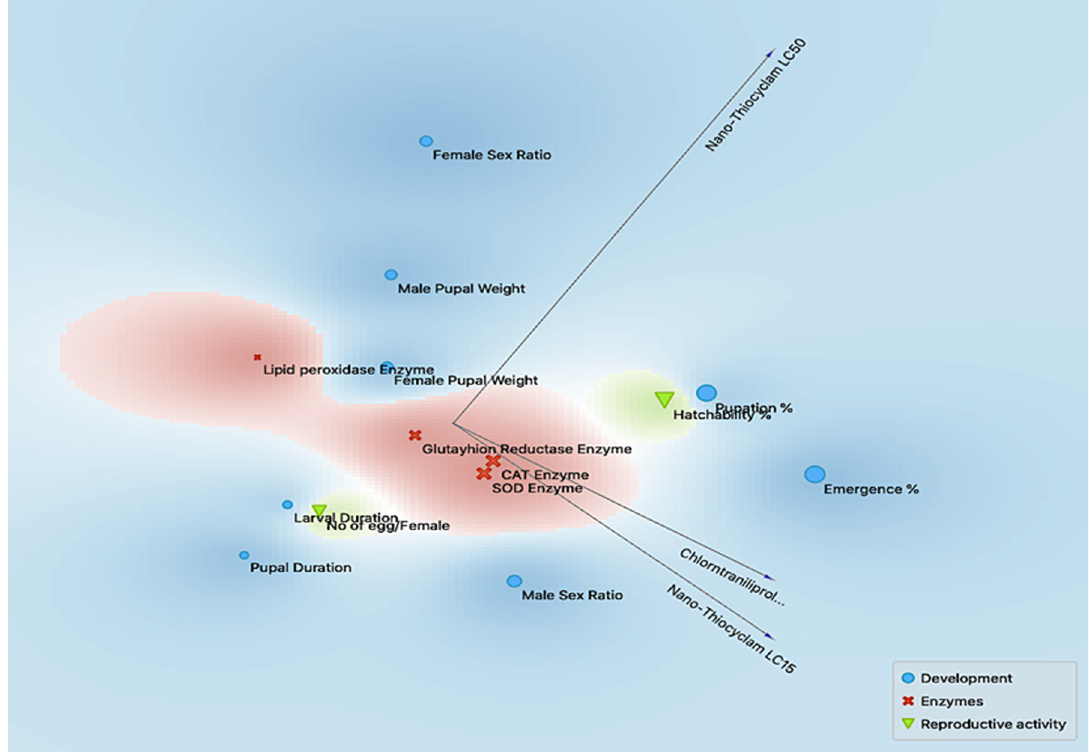
Fig 5. Multidimensional preference analysis plot summarizing the interrelationships amongst treatments, parameters, and classes.